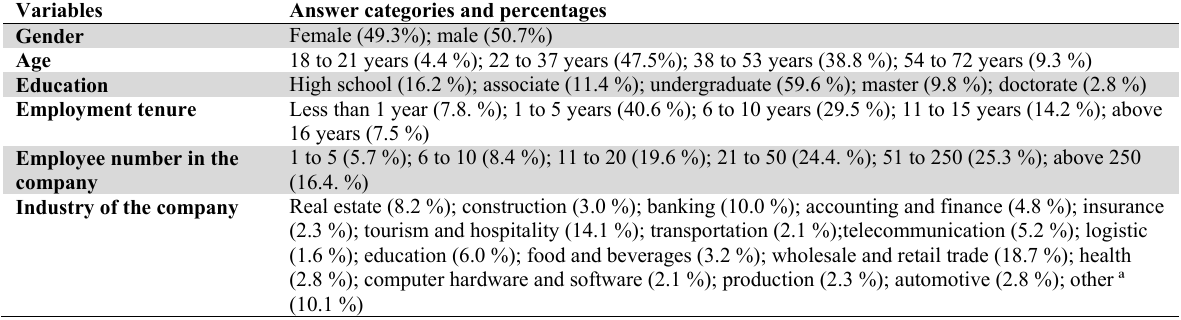
Information on the study sample